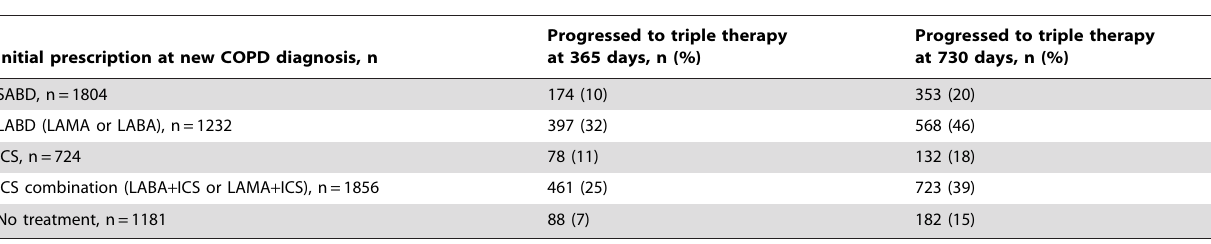
Table 4. Percent of patients that progressed to triple therapy within 2 years by index treatment prescribed.